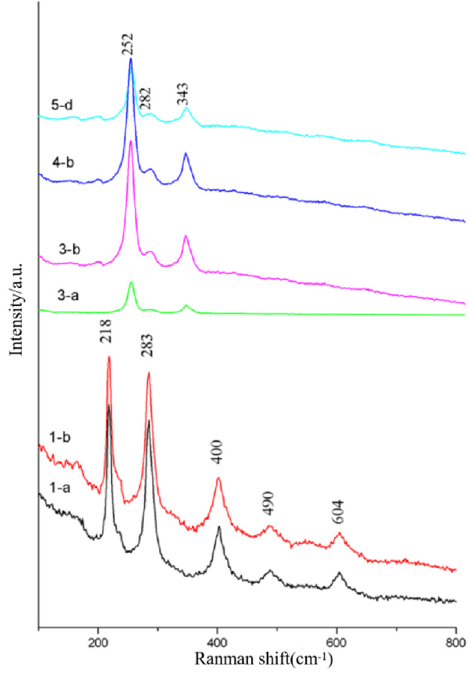
Figure 2. Raman spectra of areas 1-a, 1-b, 3-a, 3-b, 4-b, and 5-d.